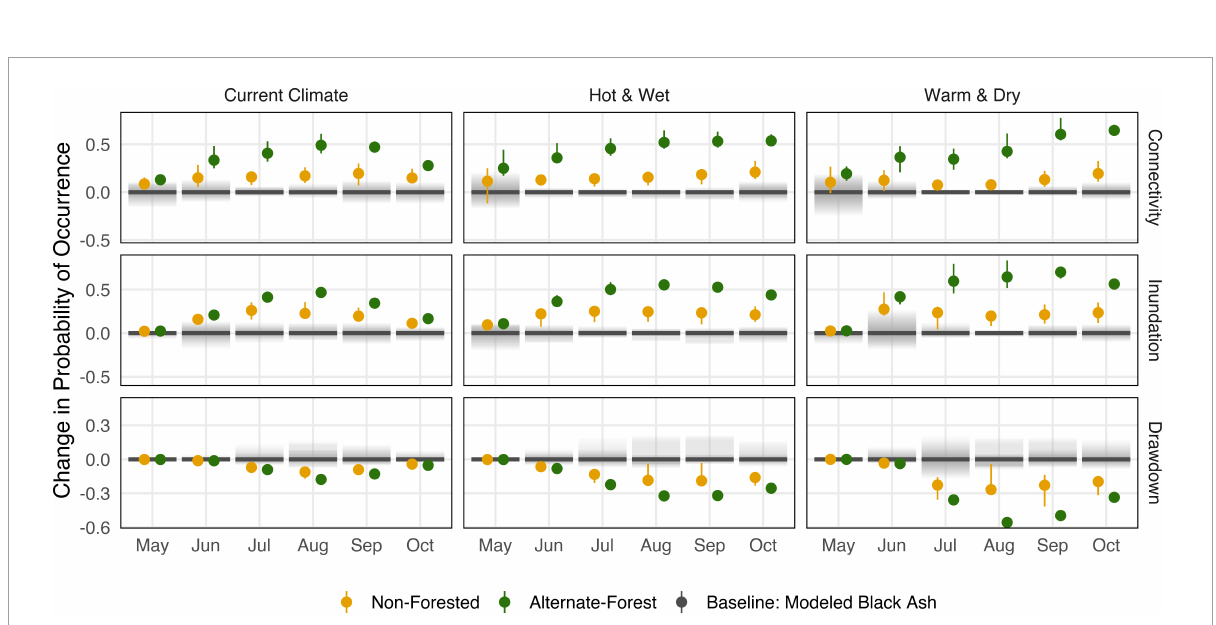
FIGURE7 Change in probability of occurrence for critical ecohydrological wetland water levels (connectivity, inundation, drawdown) under combinations of vegetative cover (black ash, alternate-forested, non-forested) and climate conditions relative to the respective climate scenario (warm & dry, hot & wet) under black ash cover. Each column compares simulated wetland response within a fixed climate scenario across multiple potential vegetative covers. Differences within a column represent the impact of EAB and potential management decisions. Values are reported as the median (point/bar) and the bounds of a 67% highest density continuous interval (HDCI, an interval, potentially asymmetric, that contains 67% of simulated values). For some combinations of vegetation conditions and climate scenarios the HDCI may be indistinguishable from the point estimate. Green and yellow colors represent alternate-forested and non-forested vegetation conditions, respectively. Gray shaded area represents HDCI of modeled